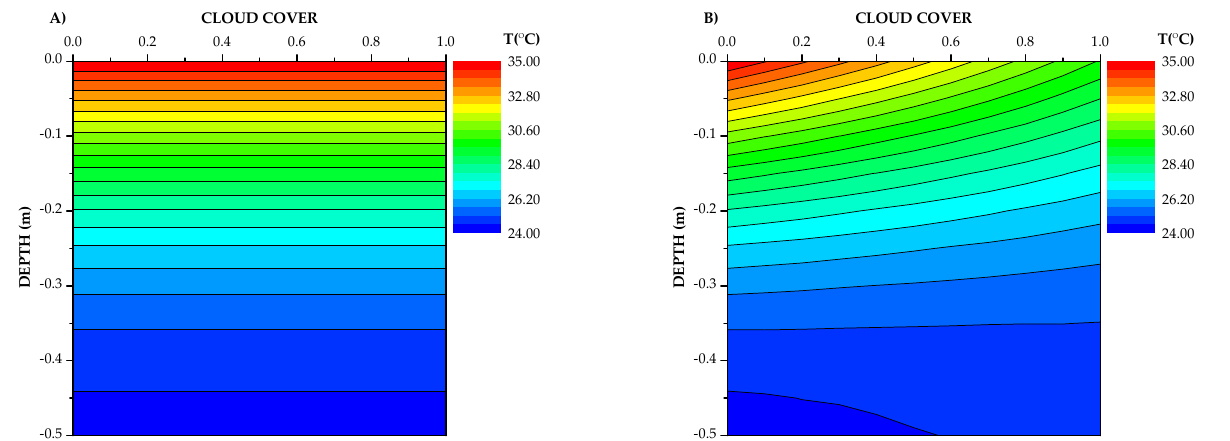
Figure 3. Soil temperature estimated by the conventional ( A ) and reformulated ( B ) models for a specific hour of the daytime period: 1:00 p.m.